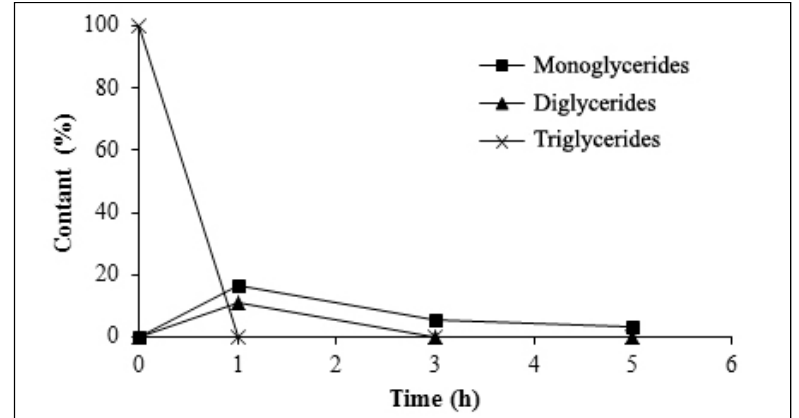
Figure 6. Change of triglycerids, diglycerides and monoglycerides during the process. Conditions: Temperature 220 °C, pressure 2.8 Mpa, water to oil ratio = 10:1 (w:w), 150 rpm.